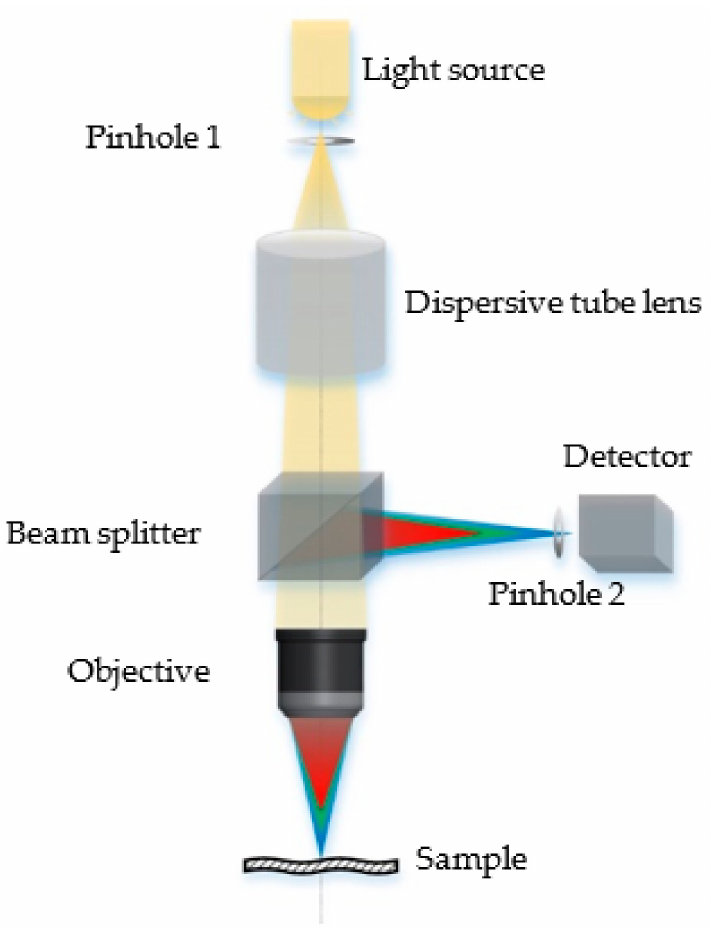
Figure 2. Principle of the chromatic confocal measurement